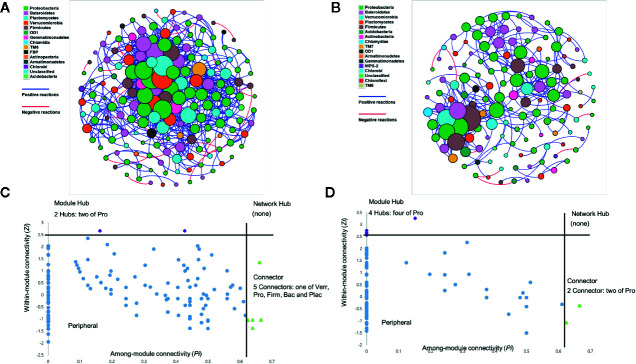
Co-occurrence network of rhizosphere of tomato treated with upland soil microbial fraction (MF) (A) and forest soil MF (B). Each node represents different operational taxonomic units (OTUs), while the edges indicate correlation between the nodes. Edges (lines) between nodes are colored blue for positive correlations between taxa; negative correlations are colored red. Node size corresponds to the number of edges. Node color represents each Phylum. Analysis of nodes to identify the putative keystone species in the rhizosphere networks (C, D). Each symbol represents an OTU from rhizosphere network of upland soil MF-treated plants (C) and forest soil MF-treated plants (D) adopted for detailed module analysis. Network hub contains Zi > 2.5 and Pi > 0.62. Module hubs have Zi > 2.5, while the connectors retain Pi > 0.62. The taxonomy information of the module hubs (purple) and module connectors (green) is named on the plot using the following abbreviations; Bac, Bacteroidetes; Firm, Firmicutes; Plac, Planctomycetes; Pro, Proteobacteria; Verr, Verrucomicrobia.